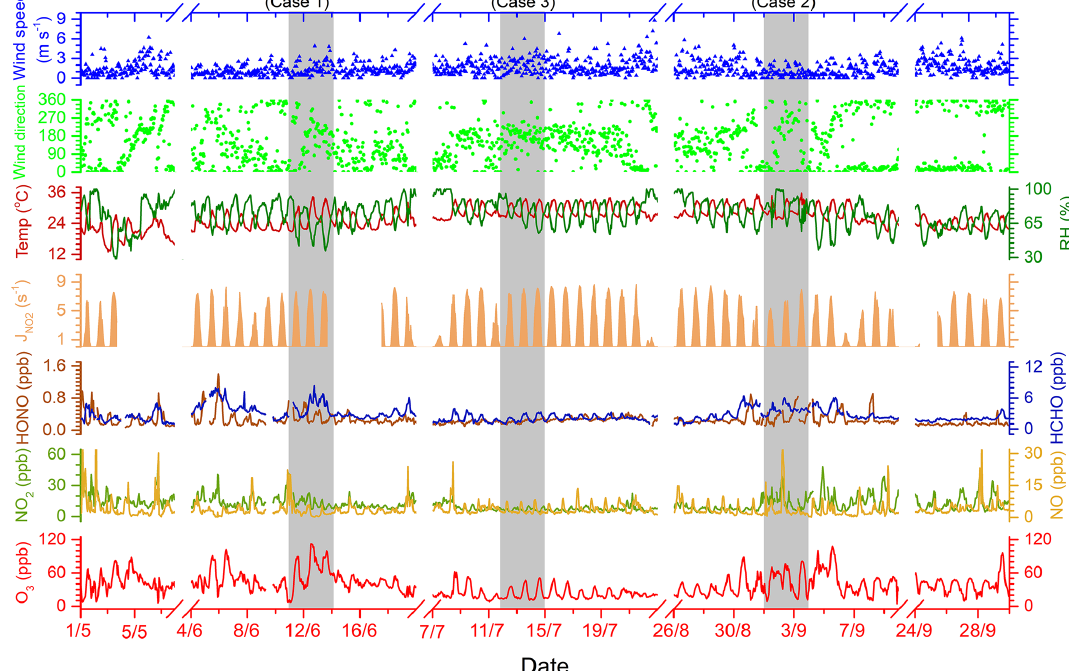
Figure 1. Time series of major pollutant mixing ratios and meteorological parameters at an urban site in Shanghai from 1 May to 30 Septem- ber 2018, with three cases